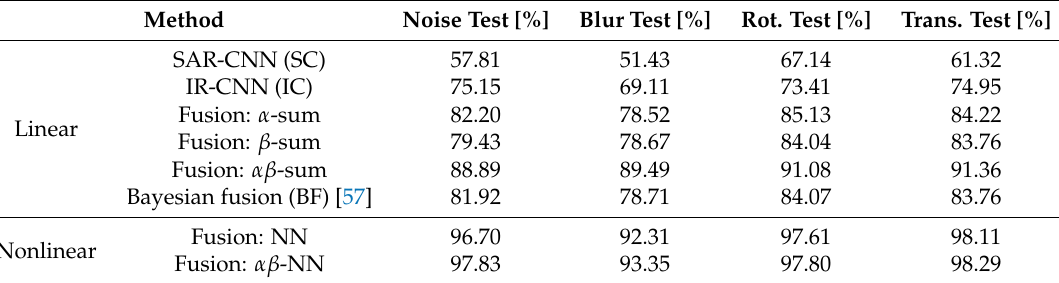
Table 3. Performance comparison of the ATR methods in terms of the average accuracy for the four types of image